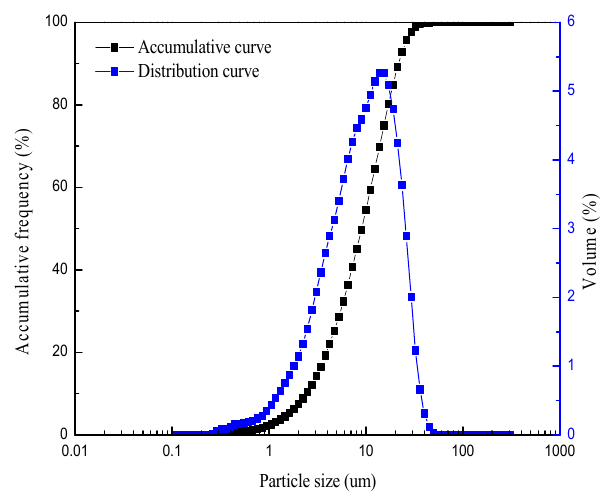
Figure 1. Particle size of the sample.